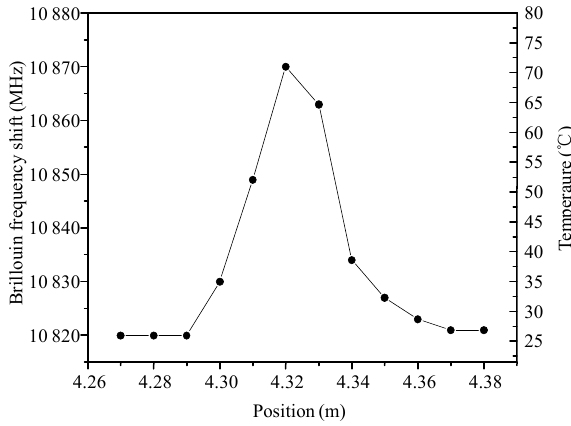
Fig. 3 Measured BFS and corresponding temperature as a function of the position. A 2-cm segment located at 4.31 cm – 4.33 cm is heated to 73 [9] ℃